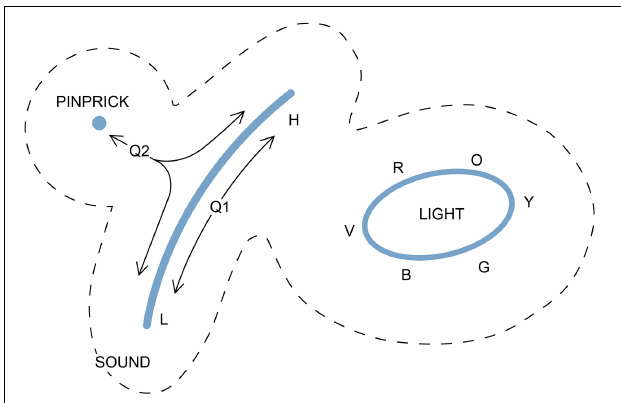
FIGURE 4 | A way of representing three experiences on a two-dimensional E-space. A pinprick is suggested here as a simple example of tactile experience, disregarding its localization, that can be represented as a point. The sensation of itch might be equally suitable. Sound, for animals that can distinguish frequencies, would be a line from low (L) to high (H) frequency. Color, as we experience it, is a closed curve, as the sequence from red to orange, yellow, green, blue, and violet (R, O, Y, G, B, V) is recursive, leaving the center of the curve for their blended combination, white light. The dotted lines are a reminder that, if these experiences are to be plotted together, there must be a zone of exclusion between them that is devoid of realized experience, as the three experiences would otherwise risk being combined in ways that would render them less distinguishable. The diagram could well have looked quite different if we consider the evolutionary past, how the three qualia originated, and the degree of homology between them. This is shown by the trajectories (arrows from Q1 and Q2). Trajectories originating at Q1 show a route by which a frequency-dependent acoustic experience might have evolved from an ur-quale that originally produced a much more limited range of that experience. Trajectories radiating from Q2 show routes by which an ancestral ur-quale common to multiple mechanosensor-based experiences might have evolved so as to separately evoke sound and tactile sensations, making these homologous as mechanosensations. The trajectories represent sequences of states that have changed over time, but points along the Q2 trajectories are ones that would have been present only in past brains, not present ones, as the SCs responsible for evoking intermediates between the qualia in question would long since have been extinguished by selection. For qualia unrelated through homology as experiences, there may be no such intervening points, and hence no access to intermediate experiences. This could be the case for light and sound for example, which share no obvious qualitative features, in which case there would be no justification for even trying to map them to the same surface. The reader is encouraged to think about how the figure might be used to illustrate the differences between a puddle-like evolutionary sequence and a tree-like one, i.e., to construct an E-space counterpart of Figure 3